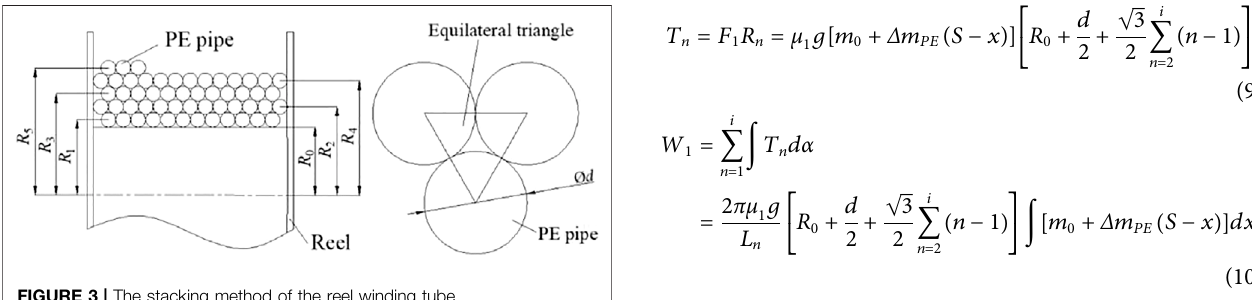
FIGURE 3 | The stacking method of the reel winding